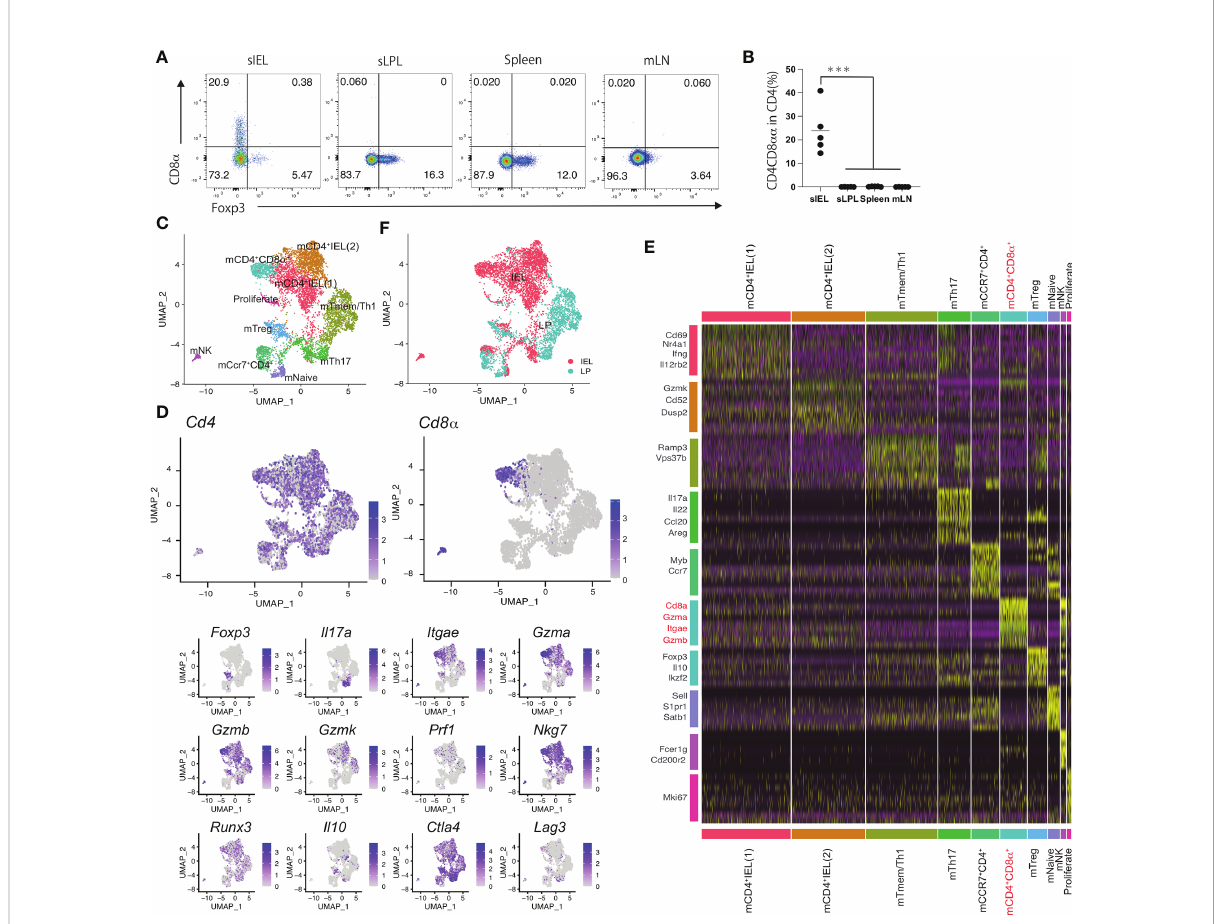
FIGURE 1 Mouse CD4 cytotoxic T cells expressing CD8a are composed of a single population (A) Eight-week-old C57BL/6J mice received the CE2-diet (Ctrl-diet; n=5/group). Representative fl ow cytometry plots for Foxp3 expression in CD4 positive lymphocytes in the small intestine intraepithelial lesion (sIEL), lamina propria (sLPL), spleen, and mesenteric lymph node (mLN). (B) Percentage of CD8 a + cells among the CD4 + TCR b + lymphocyte subset in sIEL, sLPL, spleen, and mLN. (C) Single-cell analysis was performed using CD4 + T cells in IEL and LPL from 11weeks-old WT mouse. All cells were classi fi ed into clusters (1 – 10) and analyzed using uniform manifold approximation and projection (UMAP). (D) Heat map for gene expression, for genes expressed in mCD4-CTLs ( Cd4 , Cd8 a , Gzma , Gzmb , Gzmk , Itgae , Prf1, Nkg7 , Runx3 ) and helper T cells ( Foxp3 , Il17a, Il10, Ctla4, Lag3 ). (E) Genes from each cluster (1 – 10) using data from the single-cell analysis. mCD4 + CD8 a + cluster and related genes are highlighted (F) Cells were colored in red (IEL) and blue (LPL). P -values were obtained using the Student ’ s t -test. ***<0.001. Data are shown as the mean ± SEM (B) or ± SD (C) from individual mice (n = 5 for A) and are representative of two independent